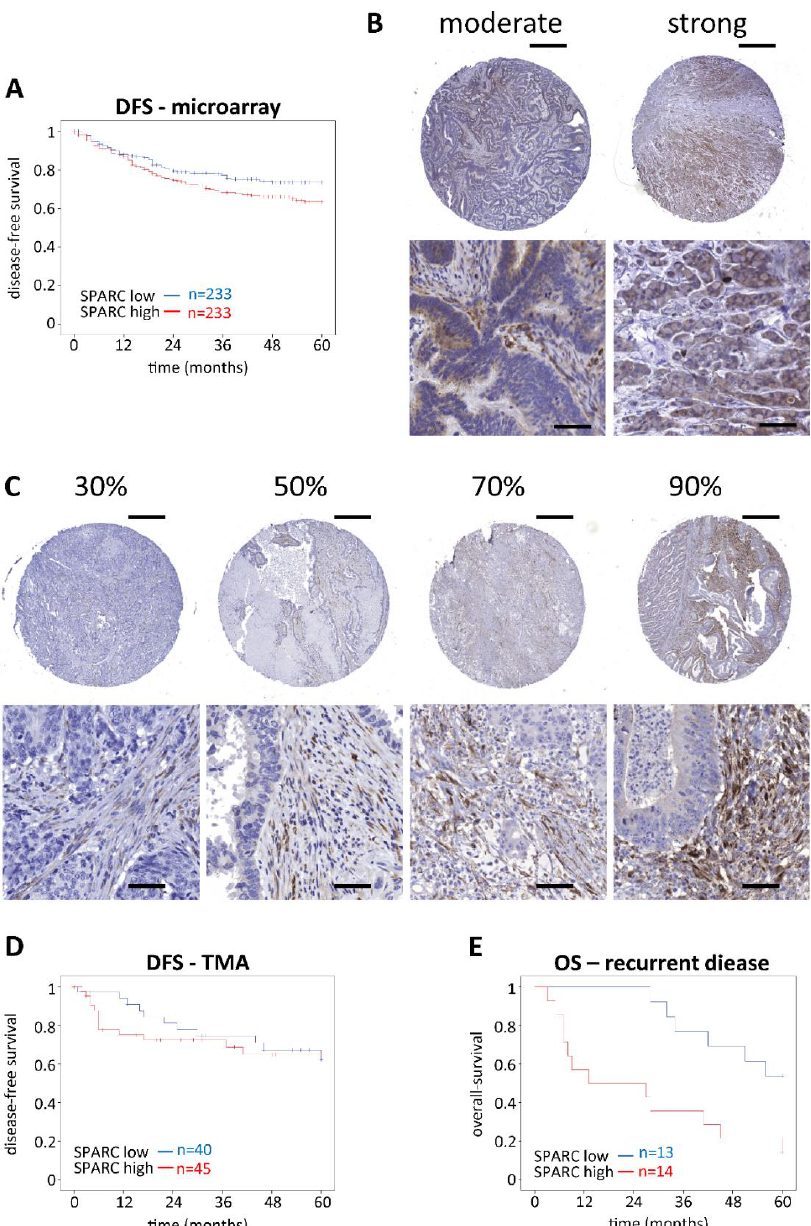
Figure 1. Impact of SPARC expression/abundance on OS and DFS. ( A ) Kaplan-Meier curves were plotted by choosing the cutoff at the median SPARC mRNA expression (microarray, n = 466). Patients with high SPARC expression had a decreased 5-year DFS ( p = 0.048). ( B,C ) Tissue microarray slides were stained with monoclonal anti-SPARC antibodies, scanned as described in materials and methods, and scored for positively stained cells in epithelium and stroma separately. The panels show representative examples for positive epithelium ( B ) and different levels of SPARC-positive stroma ( C ). Scale bars for the overview pictures (upper right corner) represent 500 µm. Scale bars for the zoomed images represent 50 µm. ( D,E ) For Kaplan-Meier analysis, the cut-off was again set at the median of positive stromal SPARC %. Stromal SPARC abundance did not affect 5-year DFS ( D ) ( n = 85). Patients with disease recurrence ( n = 27) had a reduced OS when their primary tumors were highly positive for stromal SPARC ( E ) ( p = 0.007). All statistical analyses were performed by using Log Rank tests. OS, overall-survival. DFS, disease-free survival. TMA, tissue microarray.